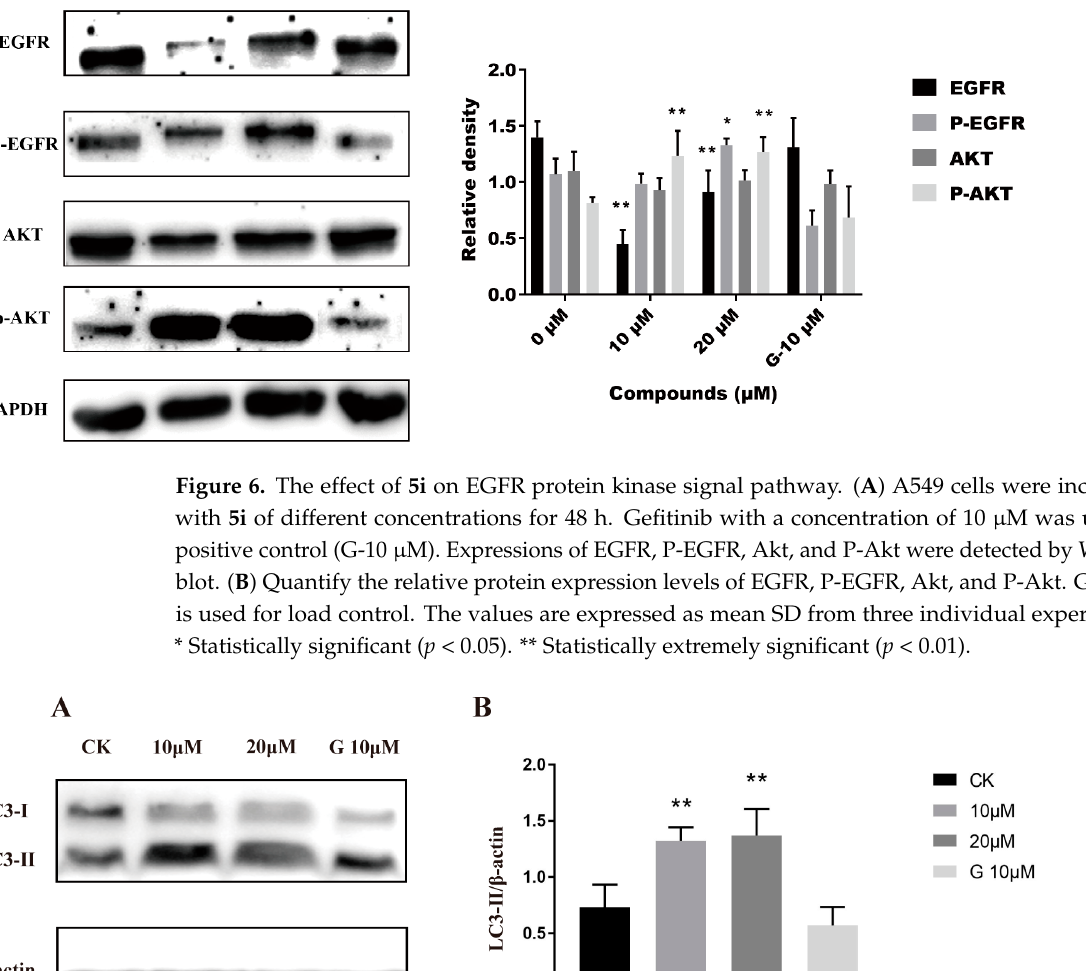
Figure 6. The effect of 5i on EGFR protein kinase signal pathway. ( A ) A549 cells were incubated with 5i of different concentrations for 48 h. Gefitinib with a concentration of 10 μ M was used as positive control (G-10 μ M). Expressions of EGFR, P-EGFR, Akt, and P-Akt were detected by Western blot. ( B ) Quantify the relative protein expression levels of EGFR, P-EGFR, Akt, and P-Akt. GAPDH is used for load control. The values are expressed as mean SD from three individual experiments. * Statistically significant ( p < 0.05). ** Statistically extremely significant ( p < 0.01).